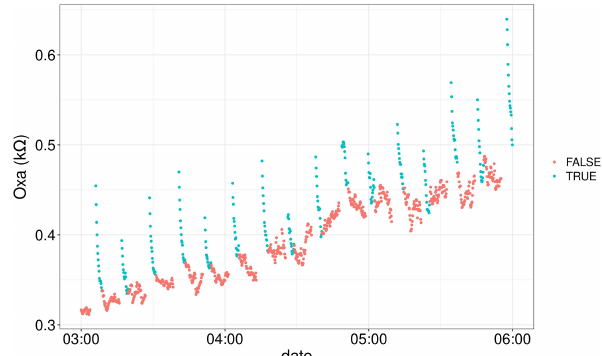
Figure 6. Example of outliers due to MOS warm-up following a GSM connection of the Zephyrs. A value of “TRUE” indicates the point was included in the 2.5min MOS warm-up period.